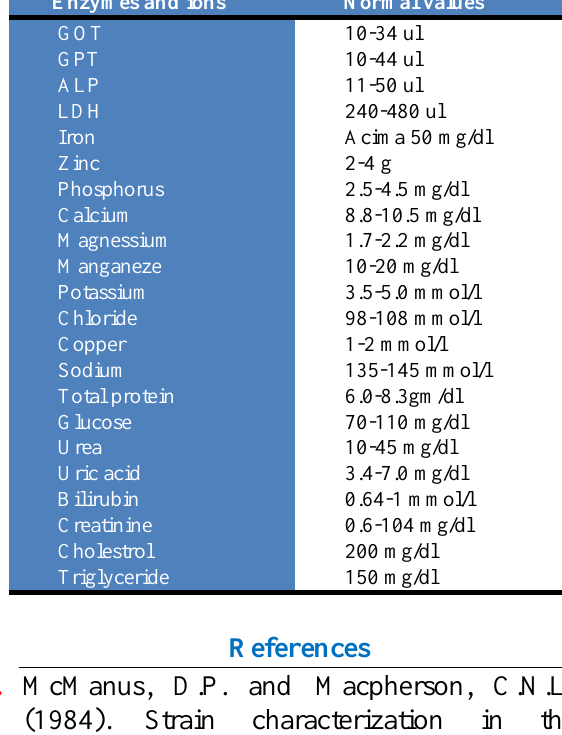
The statistical analysis has been determined by applying multivariate analysis of variance and for the comparison of mean, T-test applied to compare the means of fertile and sterile isolates of human, all have significant difference (P<0.05). Table, 2: The normal values of enzymes and ions of human